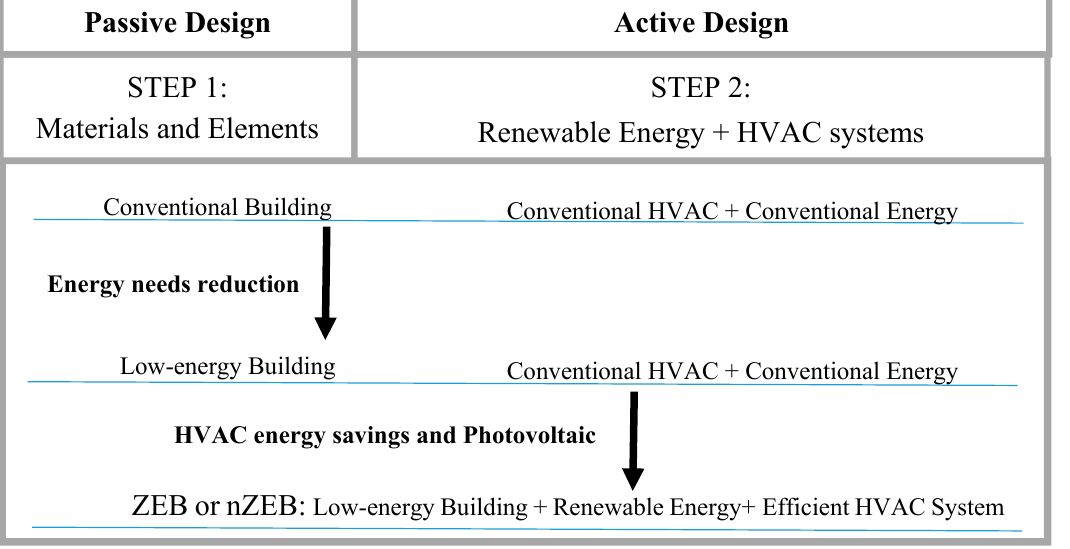
Figure 1. From conventional buildings to ZEB. HVAC: Heating, Ventilation, and Air Conditioning; nZEB: nearly Zero Energy Buildings